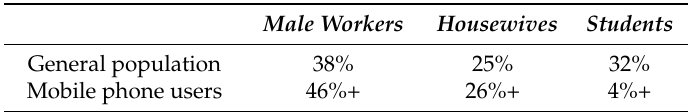
Table 7. Proportion of the three principal population